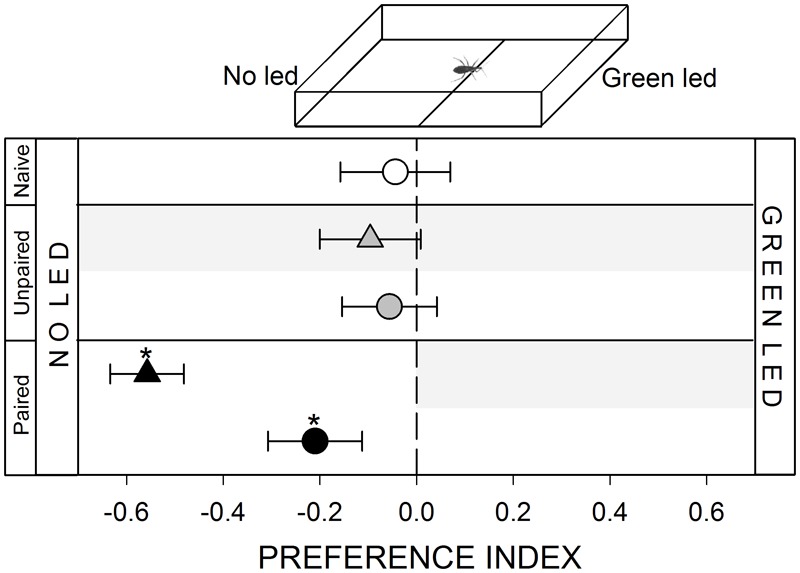
Responses of R. prolixus to a visual stimulus. No innate response was registered when insects were confronted to a “no led/green led” choice (white circle, p > 0.05). Unpaired yoke controls presented the same pattern: i.e., no preference (gray triangle and circle, p > 0.05 in both cases). During training, insects avoided the punished zone: i.e., the “green led” side (black triangle, p < 0.05). During test the no-led side was still preferred (black circle, p < 0.05) evincing an experience-dependent behavioral plasticity. Each point represents the mean (±SE) spatial preference of 30 insects individually released in a 2-choice rectangular walking arena. Asterisks denote statistical differences between the Preference Index (PI) and the value 0 (p < 0.05) evinced by One sample T-test. Gray shadows show the zone in which punishment was delivered during unpaired and paired trainings.